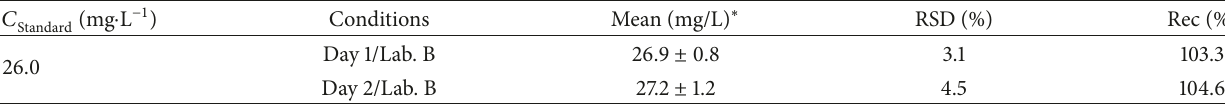
Table 4: Results of the reproducibility of the method.